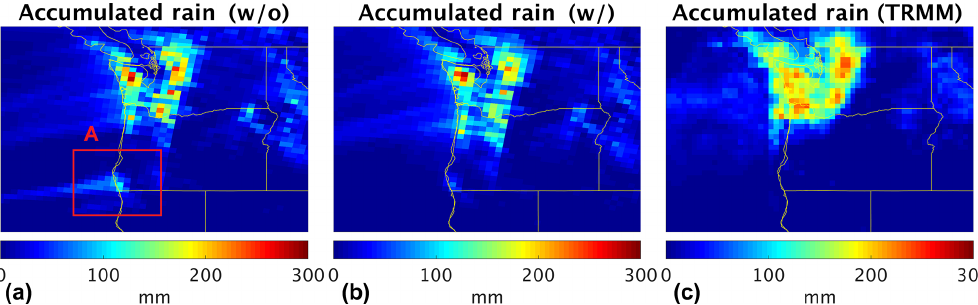
Figure 12. The simulated rainfall accumulated from 00:00 to 23:00UTC (mm) on 6 November 2006 for the model (a) without and (b) with OMI TCWV assimilation. (c) The accumulated rainfall observed by TRMM for the same time period. Note that the 3km model result is coarsened to match the resolution of the TRMM product. Box A highlights the erroneously simulated precipitation in the run without OMI TCWV data